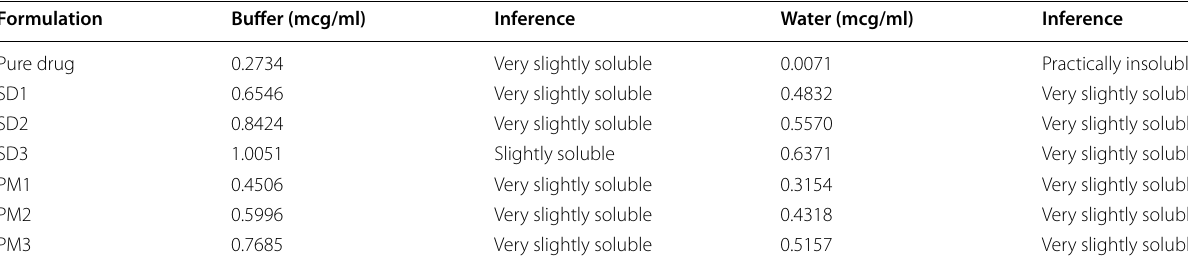
Table 7 Solubility study of solid dispersion (SD) and physical mixture (PM) Formulation Inference Inference